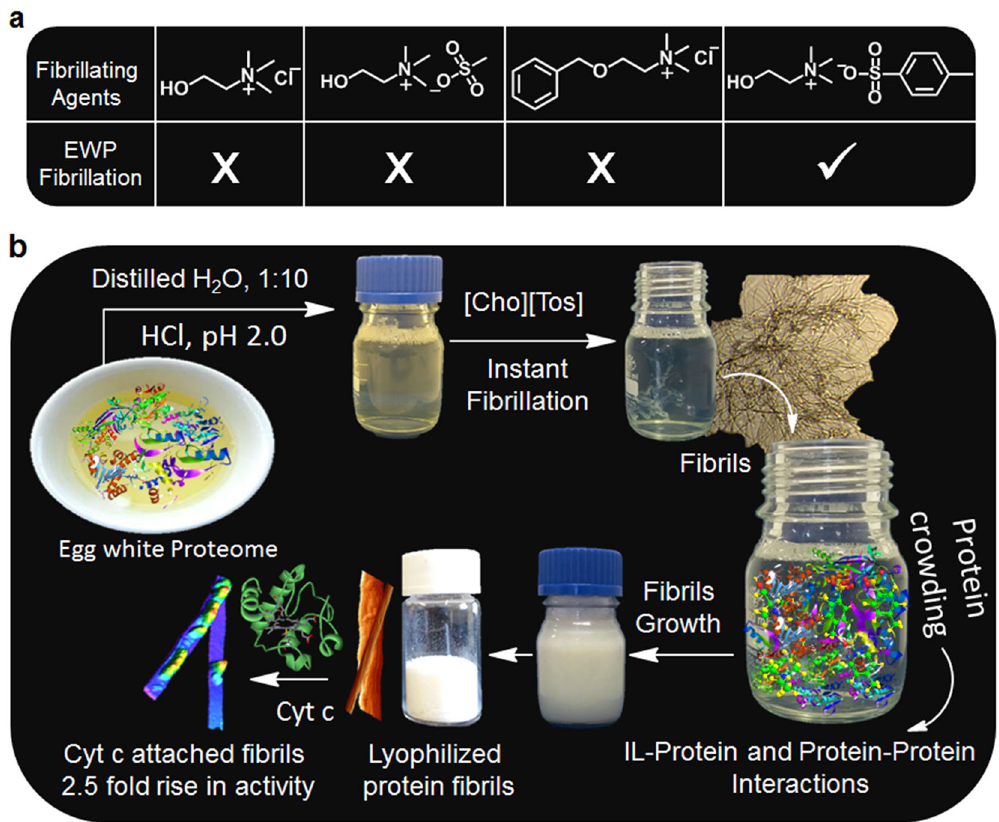
Fig. 1 Fibrillation agents and schematic representation of the work carried out. a Tested fi brillation agents to induce the fi brillation of the egg white proteome. b Schematic representation of the protein fi brils formation directly from egg white using the IL [Cho][Tos] as a fi brillation agent. The protein crowding effect responsible for fast fi brillation and the application of the prepared fi brils as supports for enzymes are also highlighted.